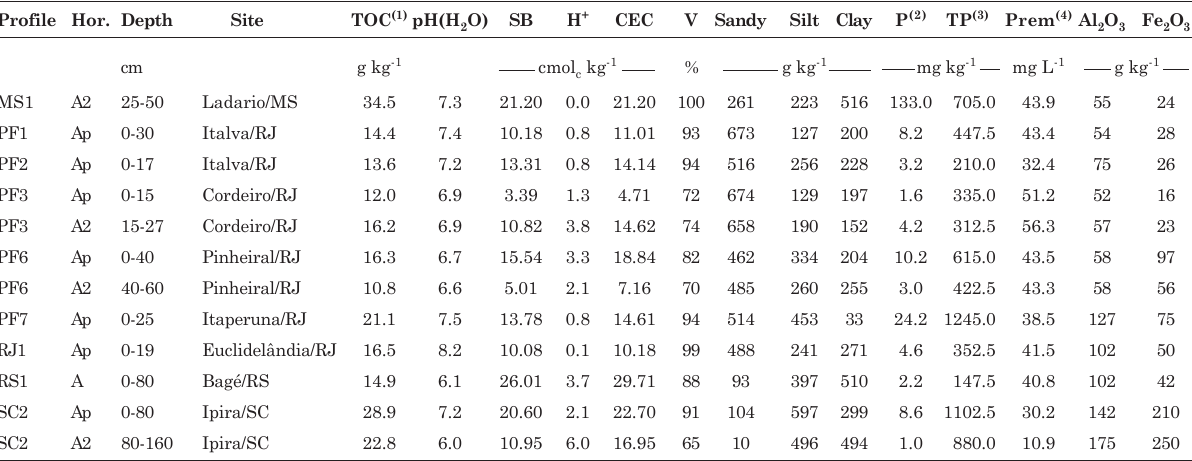
(1) TOC: total organic carbon; pH in water; SB: sum of bases; hydrogen (H + ); CEC: cation exchange capacity; Al 3+ : aluminum; V: base saturation. Source: Fontana (2009). (2) P: available phosphorus by Mehlich-1. (3) TP: total phosphorus (nitric-perchloric digestion). (4) Prem: remaining Table 2. General, morphological, chemical, and particle size characteristics of Chernozemic A surface horizon samples